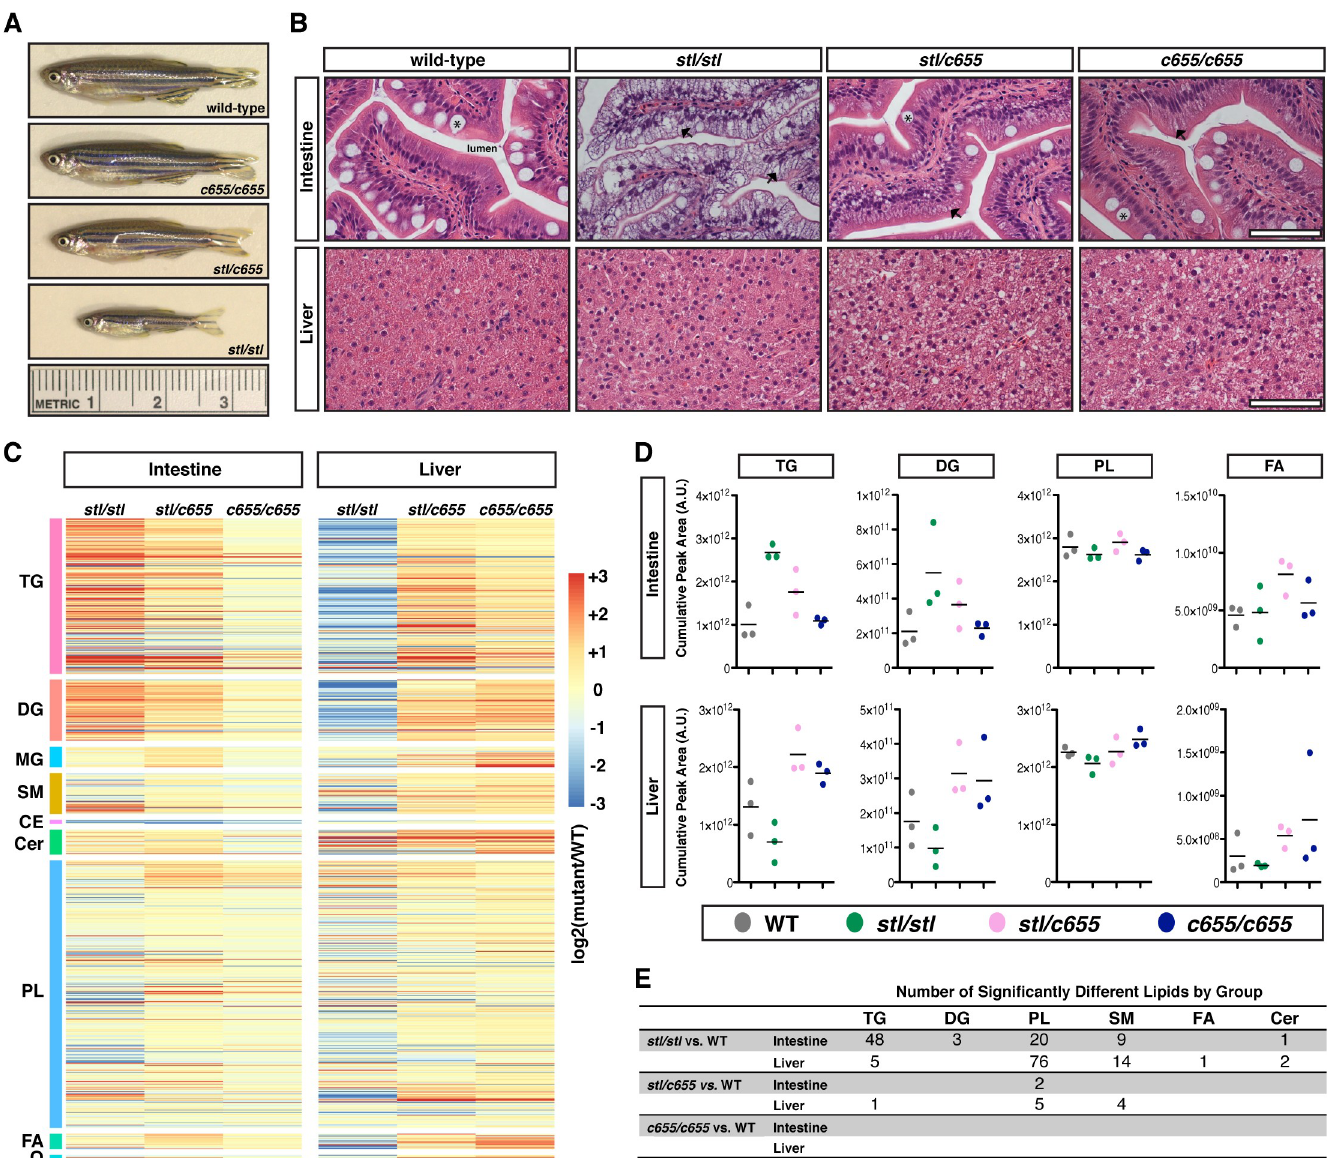
Fig 4. The stl and c655 mttp mutations have differential effects on growth and the accumulation of lipid in intestine and liver. (A) Representative images of male WT and mttp mutant fish at 12 weeks of age. (B) Representative images of H&E stained intestine and liver from adult male WT and mttp mutant fish (7.5 mo), scale = 50 μ m, � indicate goblet cells, arrows indicate representative lipid accumulation in enterocytes. (C–E) Intestine and liver tissue from adult male fish were extracted based on equal concentration of protein. Tissue lipid extracts from WT and mttp mutant fish were quantitated using an HPLC system coupled to a tandem mass spectrometer (LC-MS/MS) (n = 3; 1 fish per sample/genotype). (C) Heat maps represent fold-change from WT of over 1000 individual lipid species grouped into lipid classes (triacylglycerol [TG, n = 274], diacylglycerol [DG, n = 108], monoacylglycerol [MG, n = 36], sphingomyelin [SM, n = 72], cholesterol ester [CE, n = 7], ceramides [Cer, n = 44], phospholipid [PL, n = 472], free fatty acid [FA, n = 27] and other lipids [O; including sterols, sphingosine, sulfatide, zymosteryl and wax esters, n = 10]). (D) Quantification of total intestinal and liver TG, DG, PL, and FA from mutant lines as expressed as a sum of lipid group (n = 3). For additional lipid groups, see S11 Fig. (E) The number of individual lipid species data from panel (C) that are statistically different from WT (adj. p <